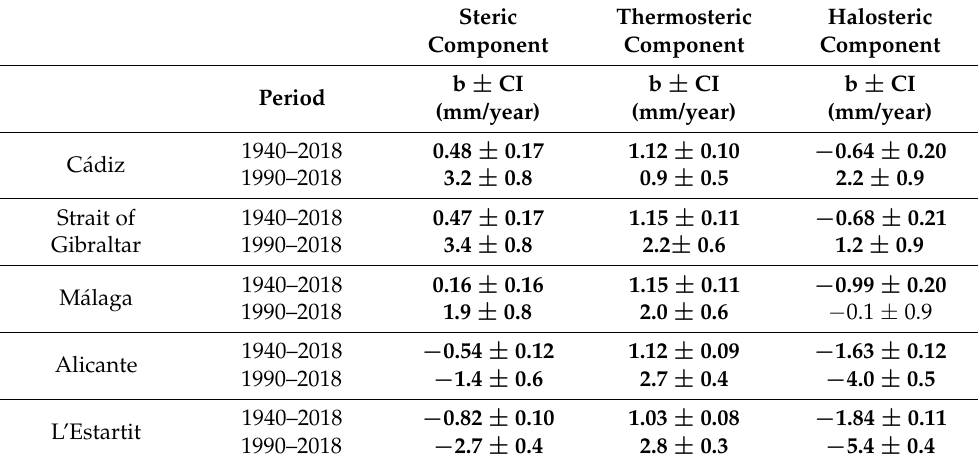
Table 3. Linear trends for the steric, thermosteric, and halosteric contributions of sea level estimated from EN4 gridded temperature and salinity profiles. Those trends statistically significant at the 0.05 significance level are typed in bold.